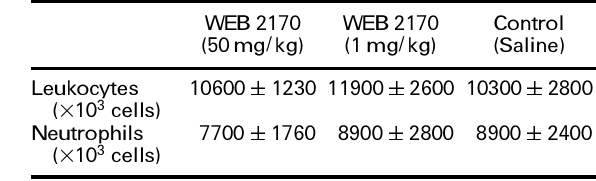
Table 3. Failure of WEB 2170 to inhibit LPS-induced recruit- ment of leukocytes and neutrophils into rat air pouches. The effects of WEB 2170 (0.05 and 1 mg / kg, i.p., 0.5 h before LPS) were evaluated for the dose of 200 ng of LPS (2 h, into the pouches). Results (mean SEM of total num- ber of cells per pouch, n = 5) of each single experiment are reported. No result was statistically different from the control LPS group WEB 2170 (50 mg / kg)